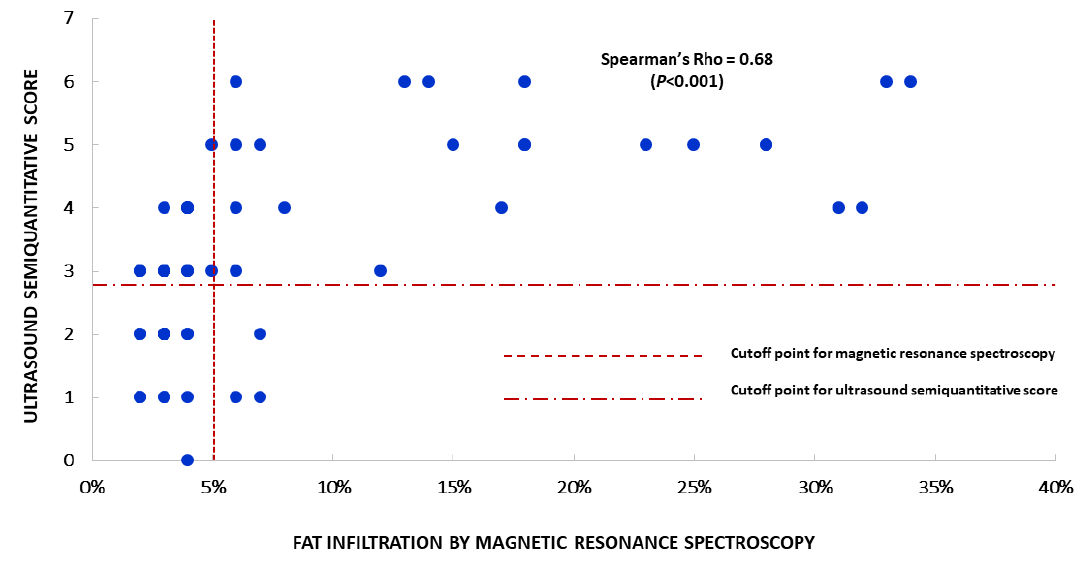
Figure 2. Plot of the ultrasound semi-quantitative score of liver fat versus the percentage of fat infiltration determined by magnetic resonance spectroscopy, in all participants. Each point denotes the score assigned to that given percentage of fat infiltration.